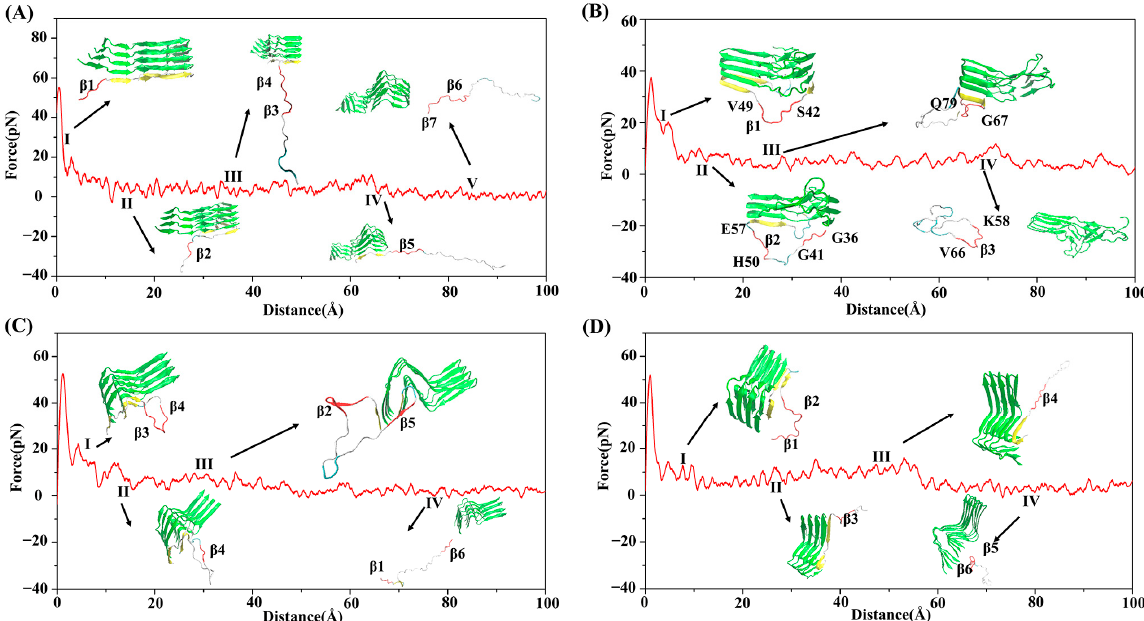
Figure 3. Changes in the secondary structure as a function of time. ( A ) Chain ‐ 1 in human brain system. ( B ) Chain-1 in cofactor-tau system. ( C ) Chain-1 in cofactor-free system for path1. ( D ) Chain-1 system. ( B ) Chain ‐ 1 in cofactor ‐ tau system. ( C ) Chain ‐ 1 in cofactor ‐ free system for path1. ( D ) Chain ‐ in cofactor-free system for path2. 1 in cofactor ‐ free system for path2.